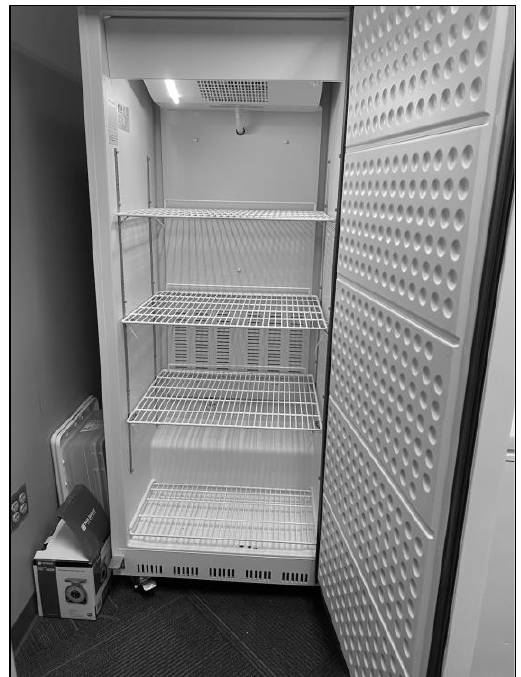
Figure 1. Empty Fridge in the Student Food